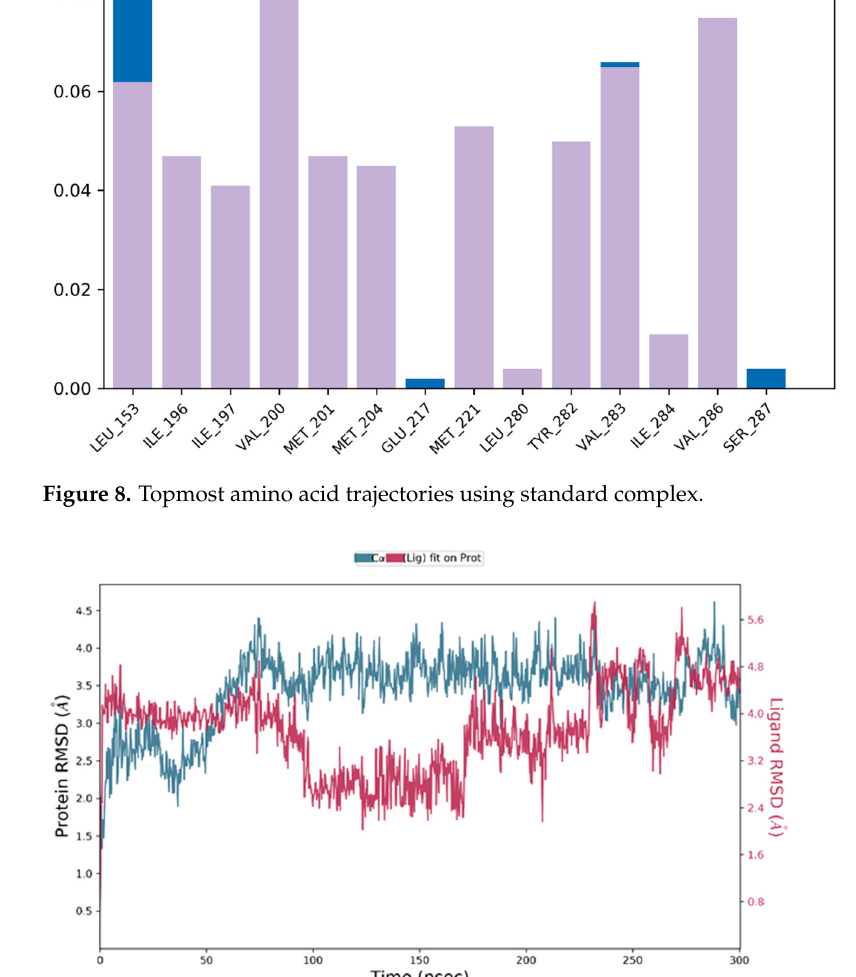
Figure 9. Root mean square deviation of 2,2-diphenyl-1,3-benzodioxole with MAGE-A .